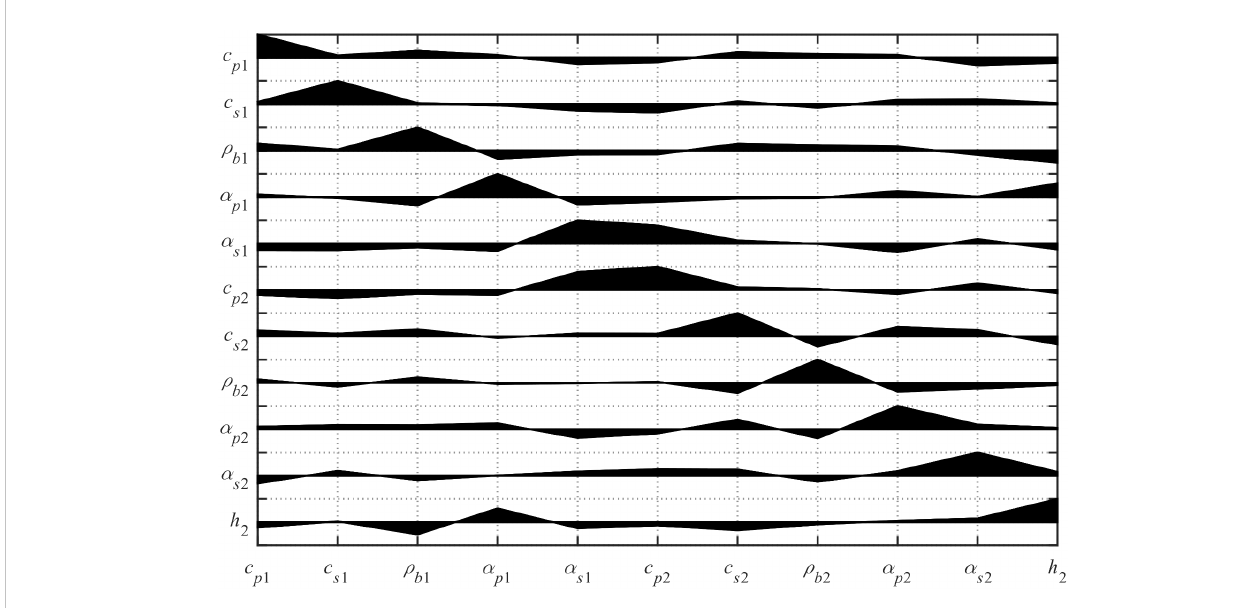
FIGURE 15 Correlation matrix diagram between inversion